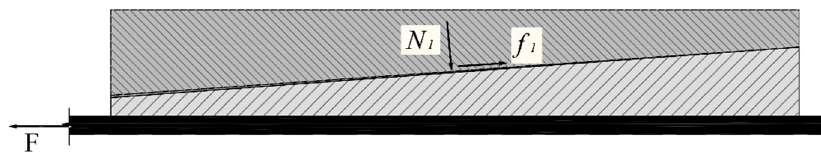
Figure 3. Force diagram of Interface 1.